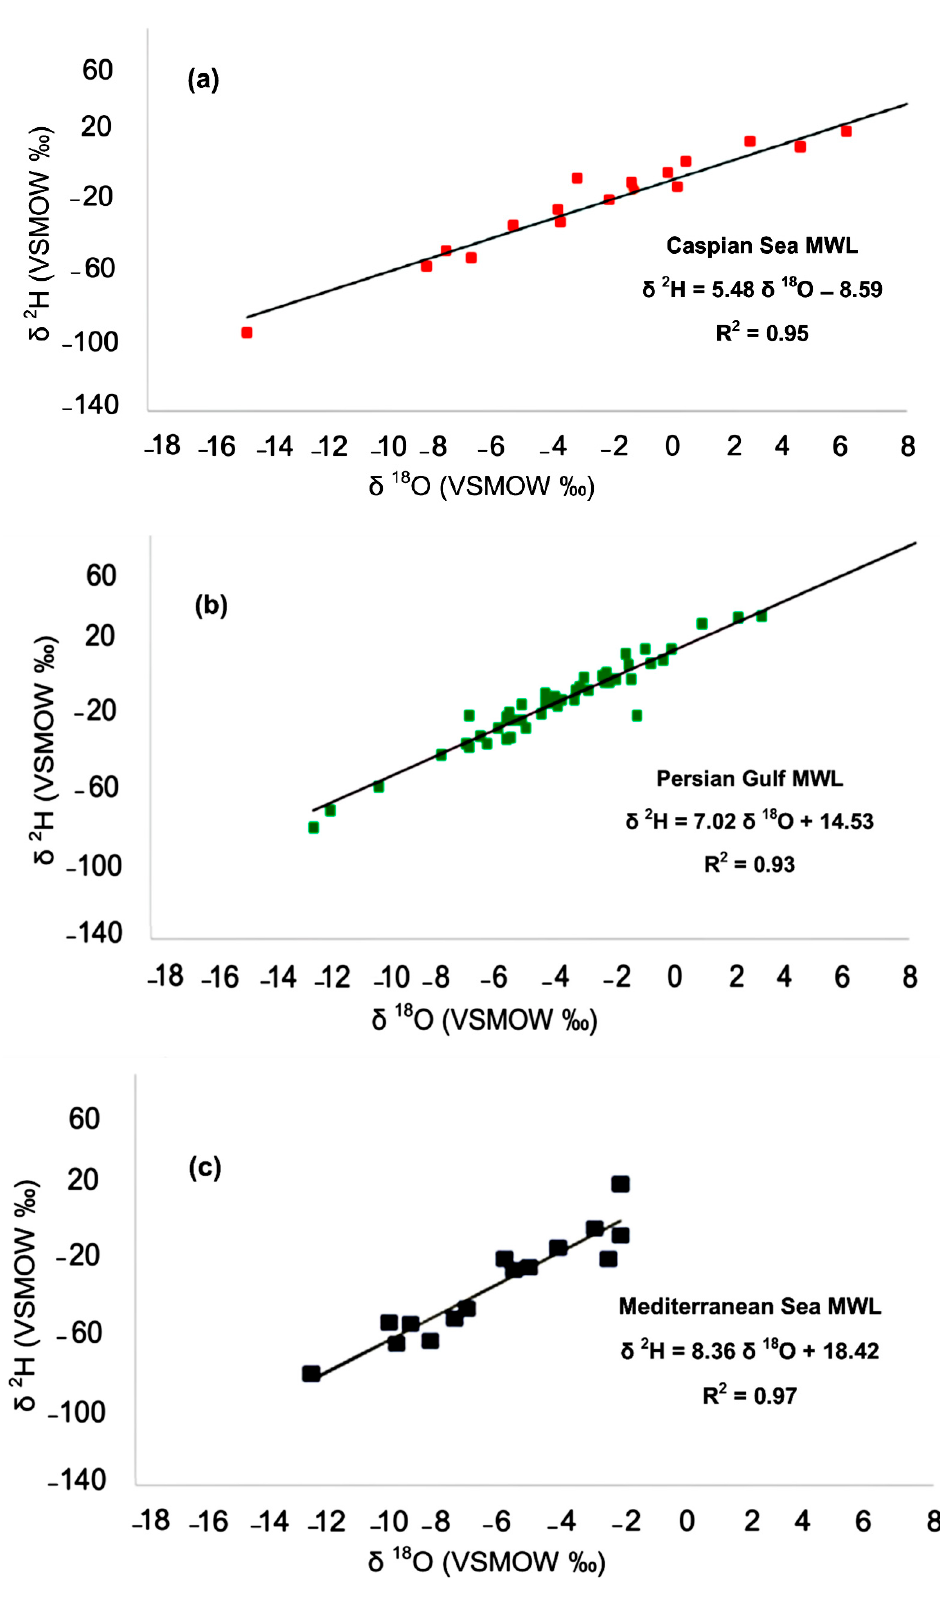
Figure 6. MWLs for specific moisture sources from the Caspian Sea ( a ), the Persian Gulf ( b ), and the Mediterranean Sea ( c ), all of which supply precipitation to Iran.